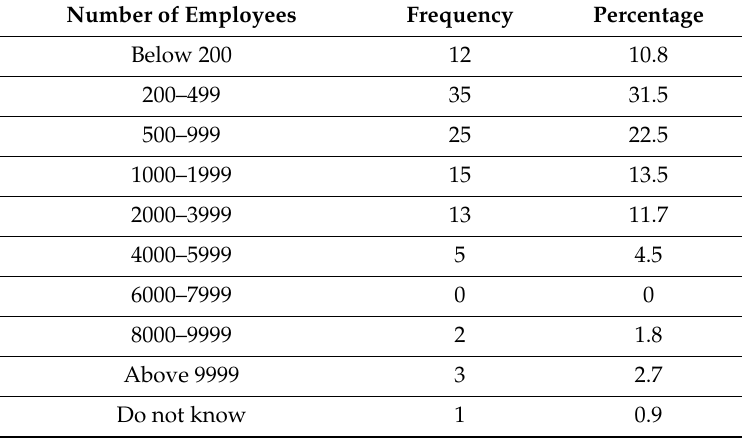
Table 2. Size and complexity of the municipalities in the